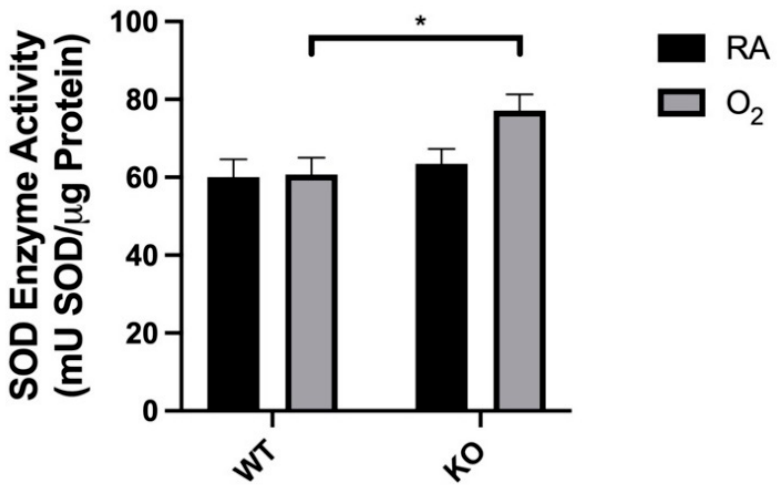
KO-O 2 mice had increased total SOD activity when compared to WT-O 2 mice (77.1 ± 4.2 vs. 60.0 ± 4.5 mU SOD activity/ µ g protein; Figure 5). Comparison of KO-RA and KO-O 2 mice did not reach statistical significance (63.5 ± 3.8 vs. 77.1 ± 4.2 mU SOD activity/ µ g protein, p = 0.06).